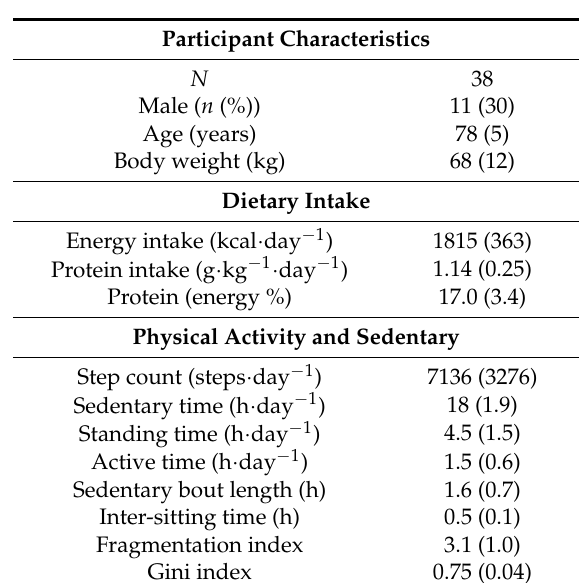
Table 1. Participant characteristics and key variable results from dietary analysis and physical activity/sedentary